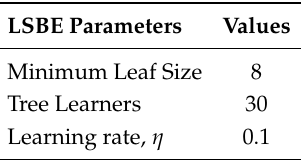
Table 1. Least-Squares Boosting Ensemble (LSBE) algorithm